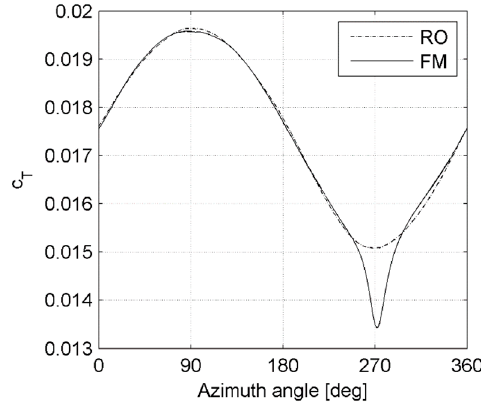
Figure 6. Torque coefficient contribution of each blade as a function of its azimuth angle: RO vs. FM.